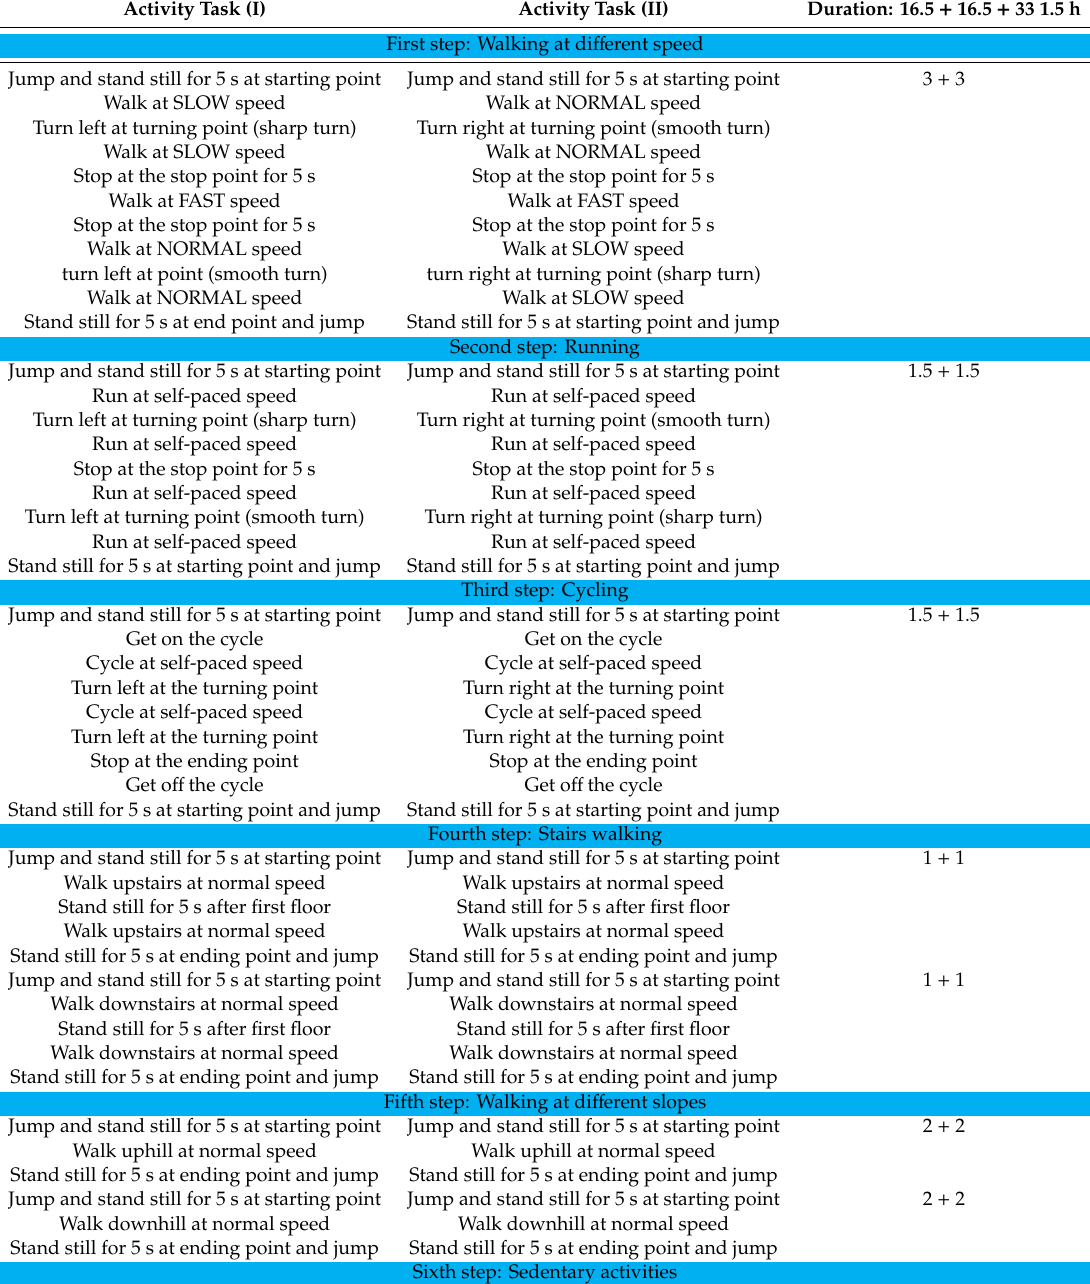
Table A1. Activity tasks for the semi-structured data